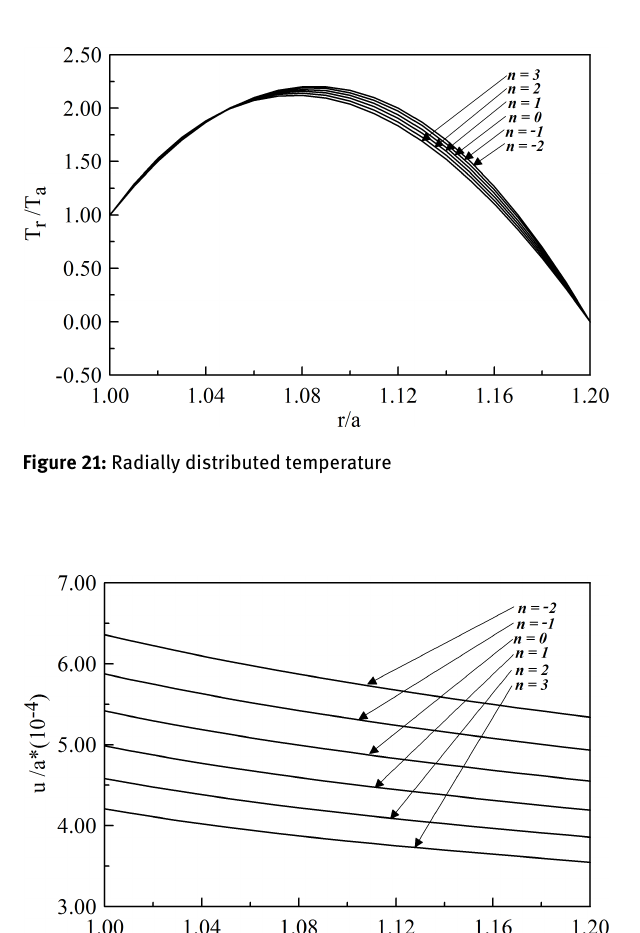
Figure 23: Radially distributed radial stress